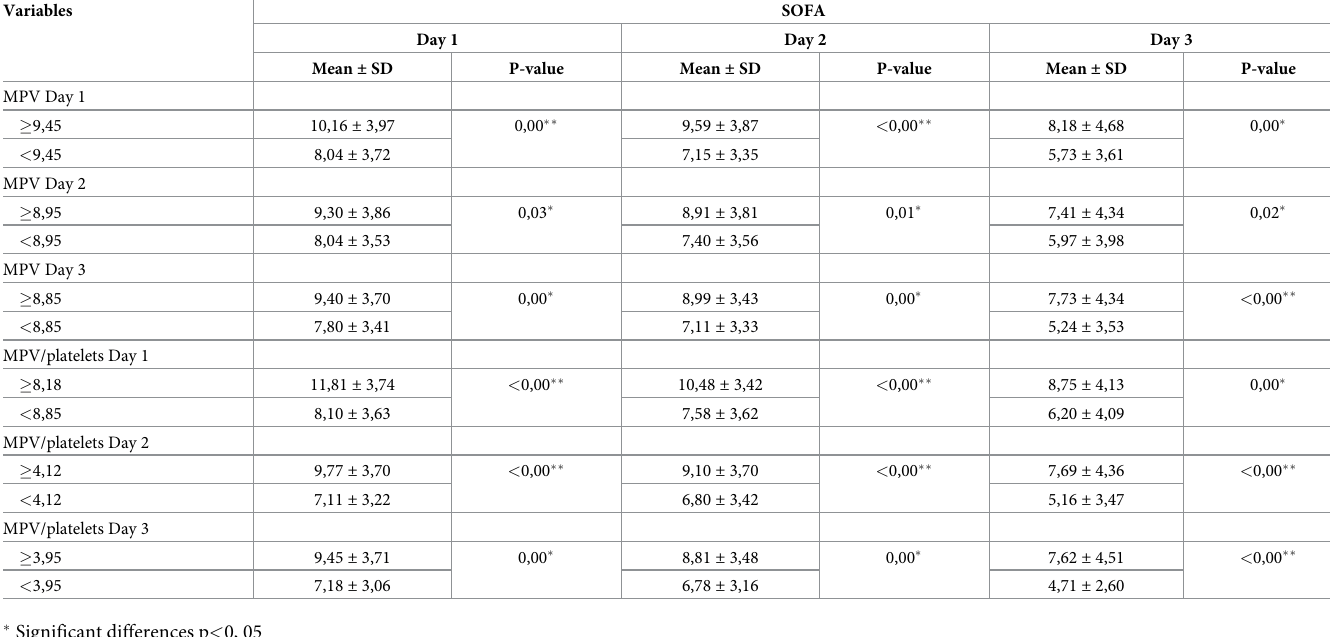
Table 2. Comparison of SOFA score base on ranges of values of MPV and MPV/platelets ratio. Variables